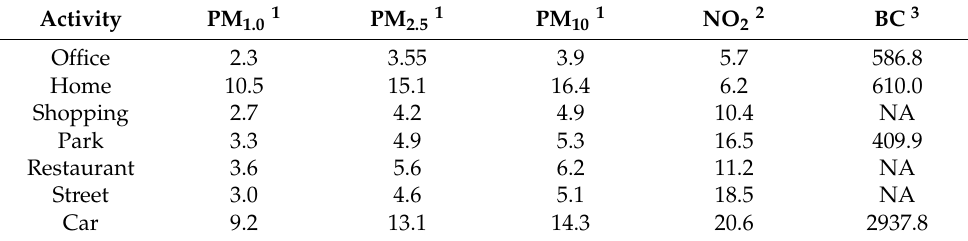
Table 3. Average air pollution level from annotated data, µ g/m 3